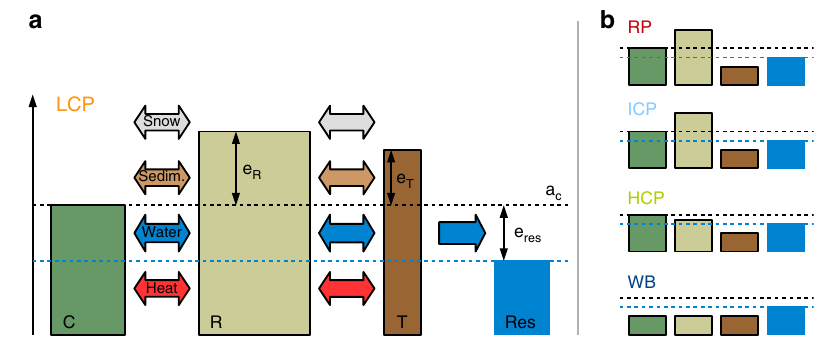
Fig. 5 Schematic of the model set-up. a Coupled tiles (polygon centres (C), polygon rims (R) and troughs (T)) and an external water reservoir (res) are used to represent surface and subsurface heterogeneities of ice-wedge terrain. The surface microtopography is re fl ected in different initial elevations ( e ) relative to the altitude of the centres ( a C ). Different subsurface stratigraphies are provided in Supplementary Tables 3 – 5. Lateral fl uxes of heat, water, snow and sediment between the tiles were calculated taking into account topological relationships among the tiles (see Supplementary Methods 2 and Supplementary Fig. 10 for details). The parameter e res was used to specify the hydrological conditions. b The microtopographic state of the landscape is de fi ned according to Eqs. (2) to (6) as relict polygons (RP), low-centred polygons (LCP), intermediate-centred polygons (ICP), high-centred polygons (HCP) or water body (WB), depending on the soil surface altitudes of the tiles ( a C,R,T ) and the elevation of the external water reservoir ( e